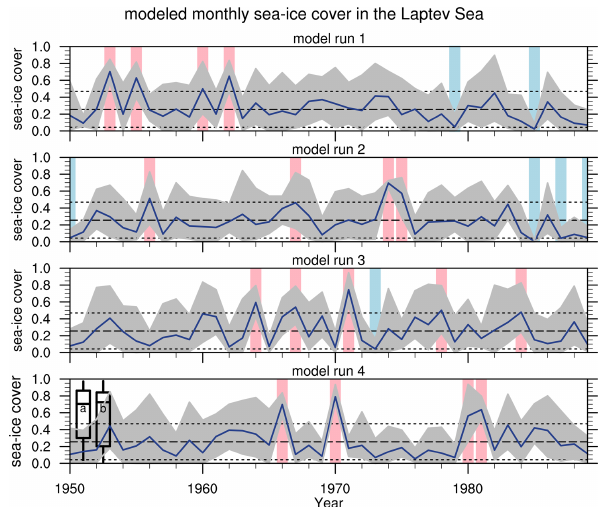
Figure 4. Monthly-mean sea-ice cover in the Laptev Sea from June to October in each year. Blue line: mean sea-ice cover over sum- mer and fall period. Grey area: range between minima and max- ima of June to October monthly-mean cover. Middle dashed line: average sea-ice cover over all June-to-October means in all years and all model runs; upper/lower dashed line: threshold for com- posite members (mean ± 1.3 standard deviation); blue/red vertical lines mark composite members for low/high sea-ice cover. The box- plots in the lower panel show satellite data for comparison, using monthly-mean ice cover in the Laptev Sea for the months June to October. The box indicates the first and third quartile, the middle line the median, and the whiskers the minimum and maximum con- centrations over all considered monthly means. Data for boxplot (a) are taken from the Hadley Centre (HadISST) for the time period 1950–1990 (Titchner and Rayner, 2014). Data for boxplot (b) are taken from the National Snow and Ice Data Center (NSIDC) for the time period 1979–1990 (Fetterer et al., 2016).